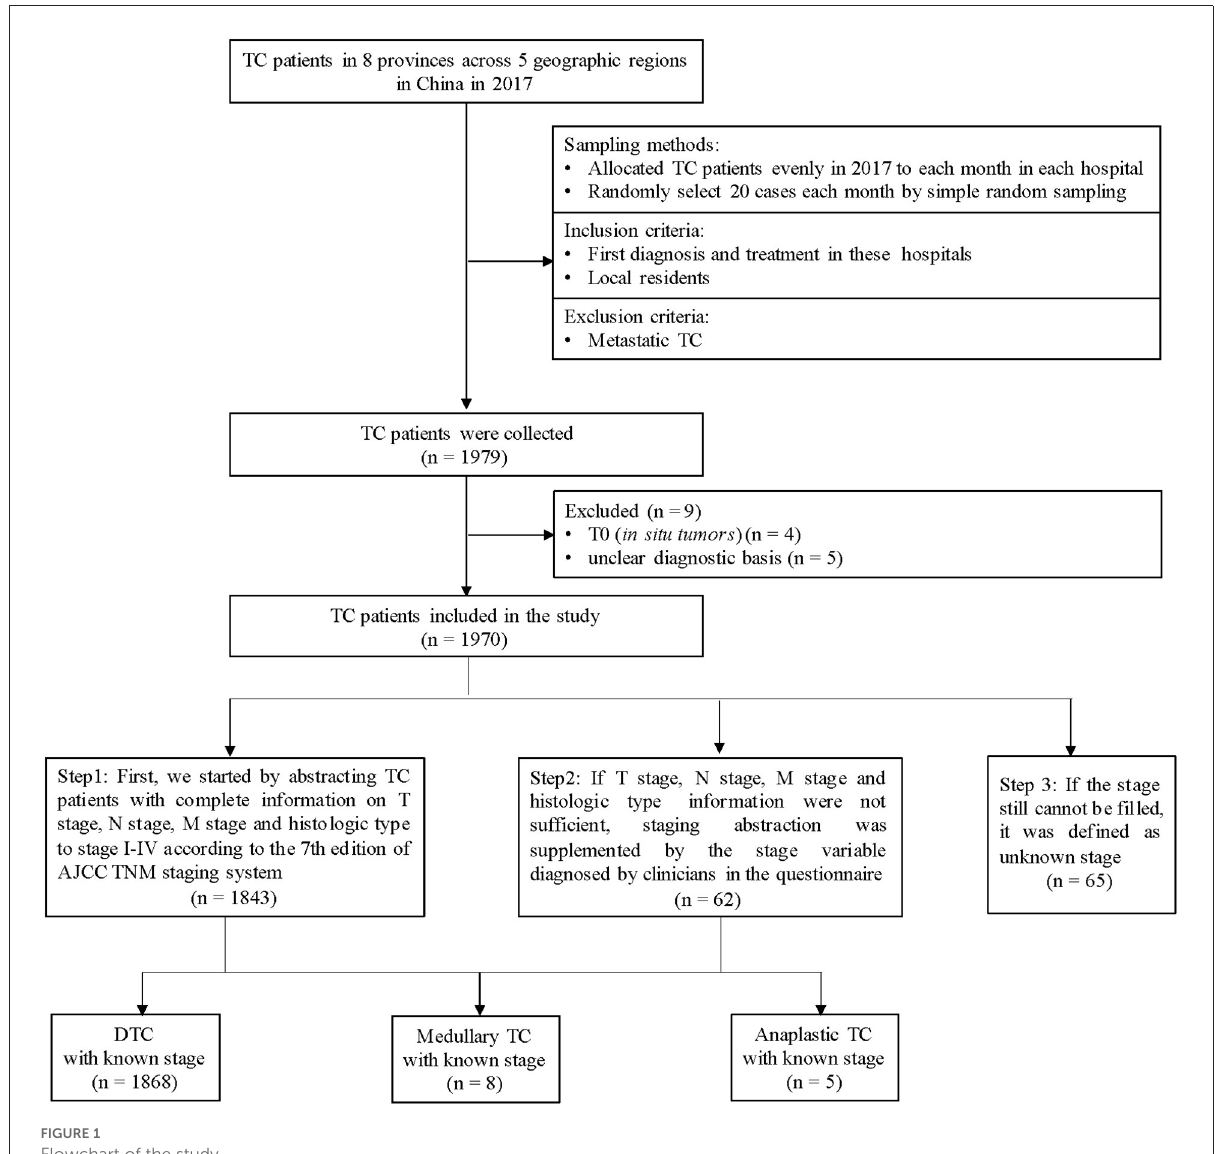
FIGURE1 Flowchart of the